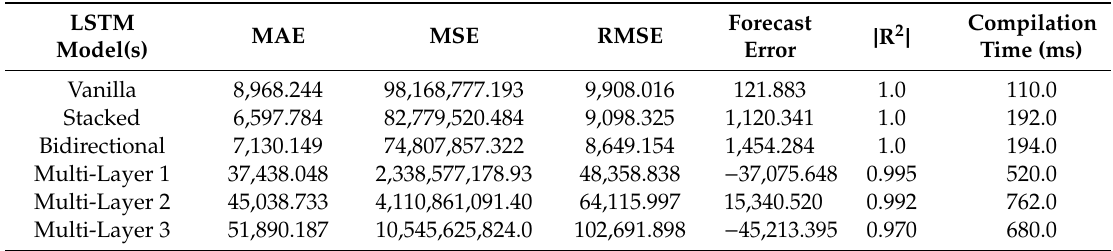
Table 11. Average performance analysis of LSTM models to forecast total cases of the “World”.